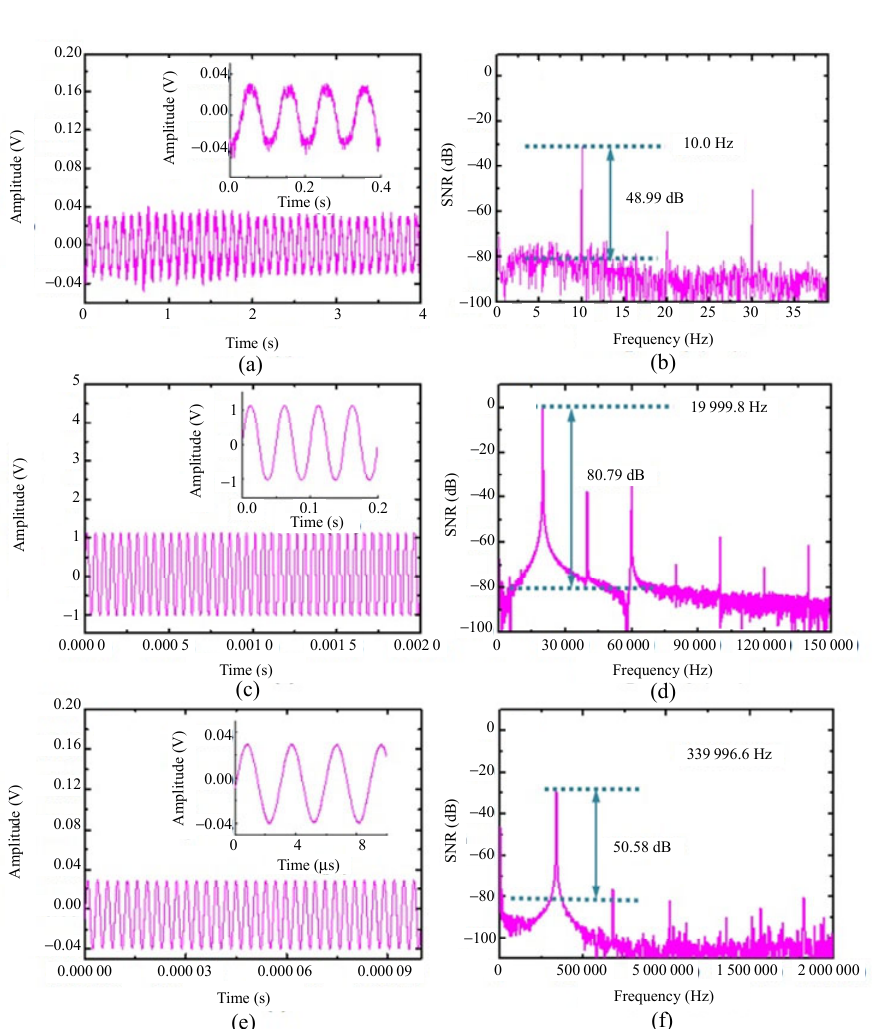
Fig. 3 Detected acoustic vibration signal by 13-mm-long DCF in the time domain [(a), (c) and (e)] and frequency domain [(b), (d), and (f)] when the vibration has the frequencies of 10 Hz [(a) and (b)], 20 kHz [(c) and (d)], and 340 kHz [(e) and (f)],